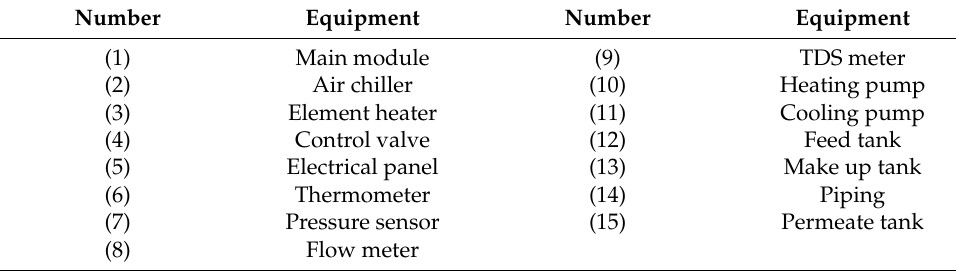
Table 4. The experimental set up details.